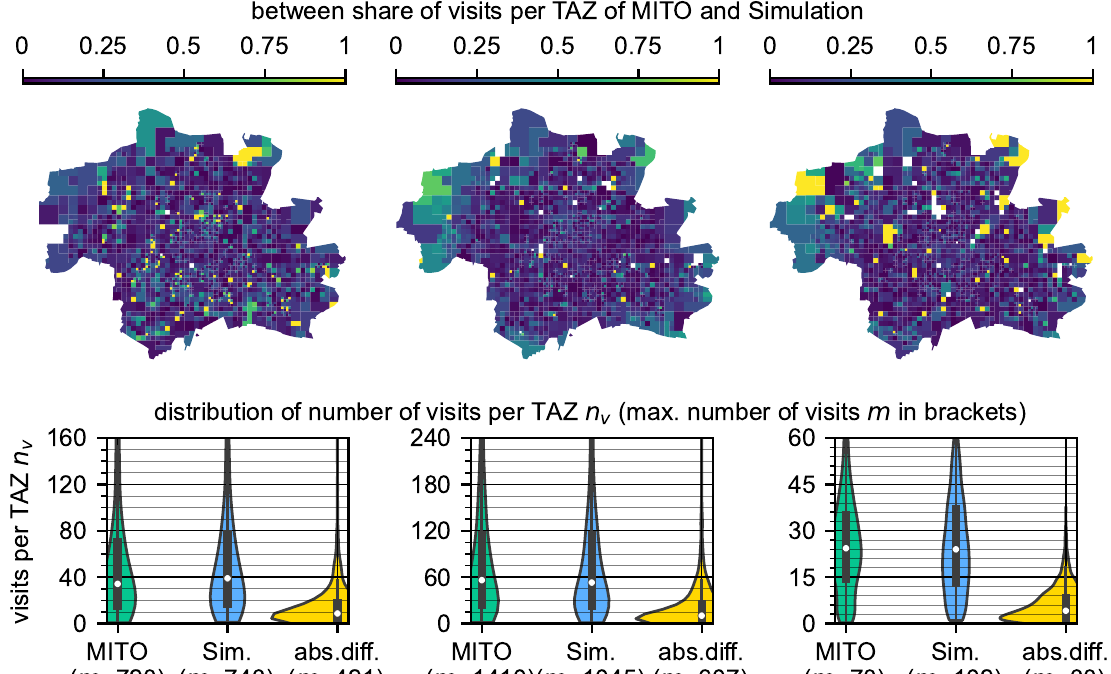
Figure 15. The heatmaps geographically compare activity locations of MITO and our simulation. The two rows from below validate whether the distribution of visits per TAZ is